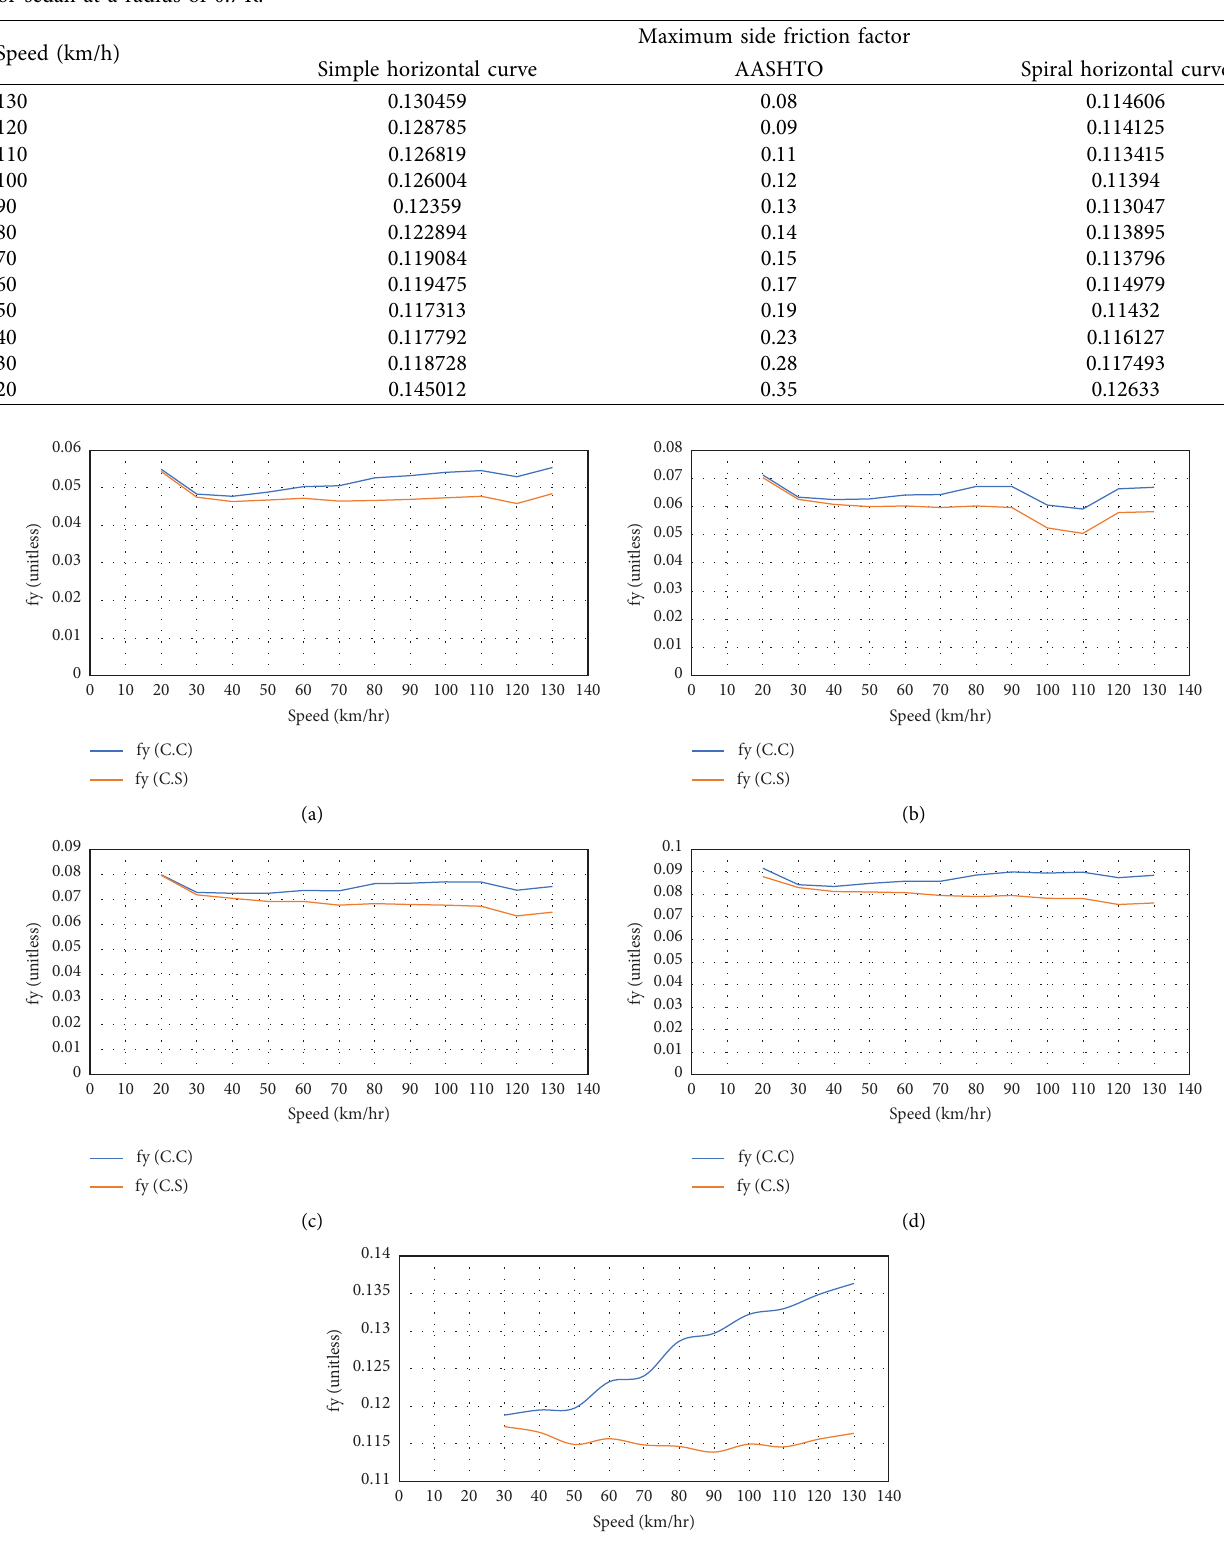
Table 16: Comparison of the maximum side friction factor between simple and spiral horizontal curves and AASHTO recommended values for sedan at a radius of 0.7R.